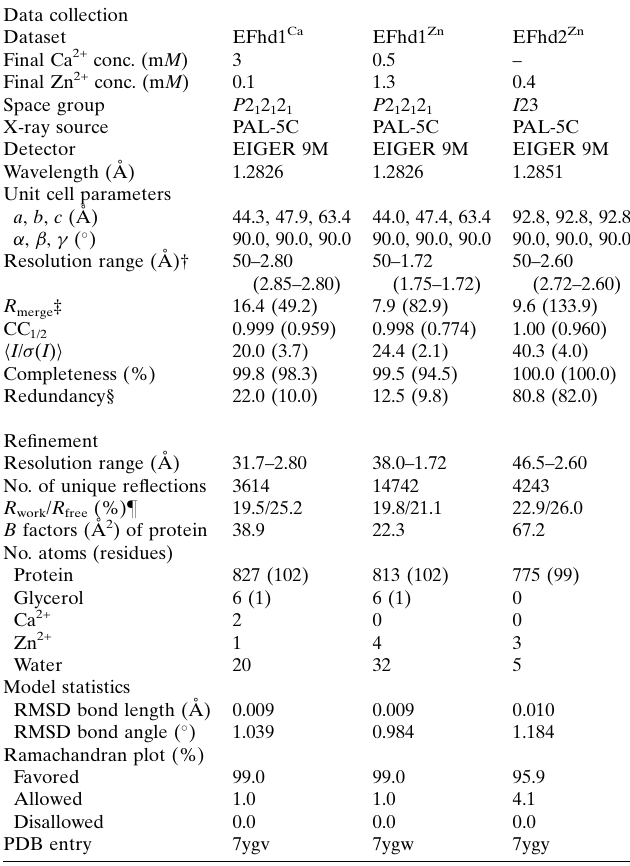
Table 1 Data collection and refinement